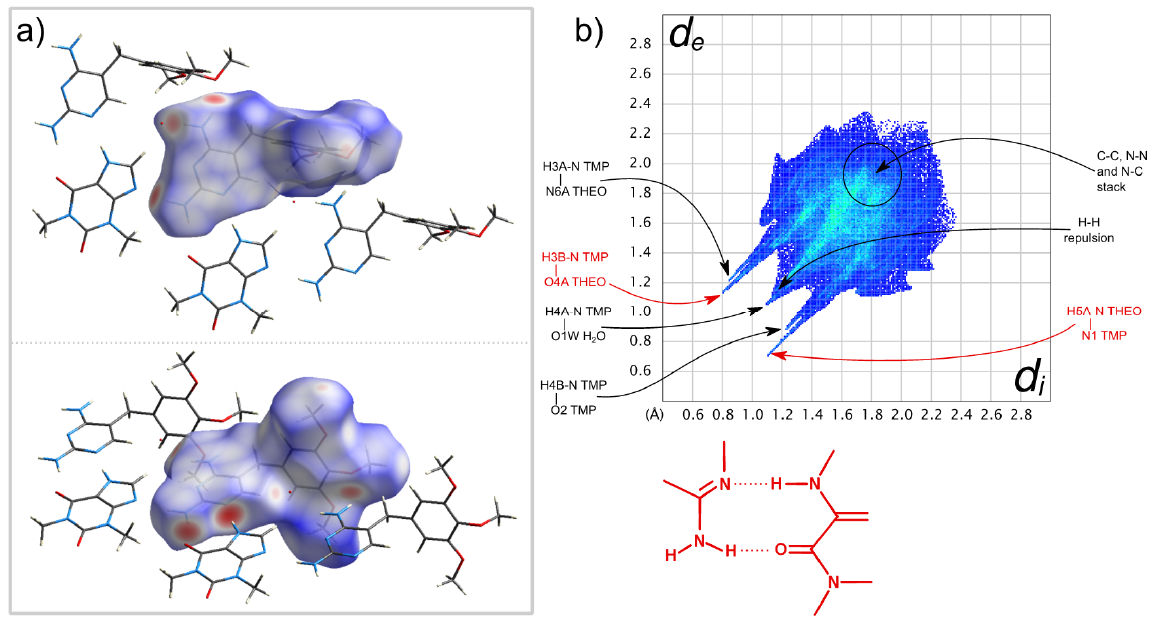
Figure 18. ( a ) Two views of the semitransparent d norm -mapped Hirshfeld surface of a TMP molecule; ( b ) Hirshfeld fingerprint plot of the TMP molecule in the (1:2) TMP:THEO (17% H 2 O) co-crystal. Some important pairs of contacting atoms are identified and assigned to fingerprint plot features. Contacts within the R 2 2 (9) synthon between the DAP scaffold and THEO, shown at the bottom, are colored in red. d i —the distance (Å) from the Hirschfeld surface to the nearest atom center in its interior; d e —distance (Å) from the Hirschfeld surface to the nearest atom center in its exterior.